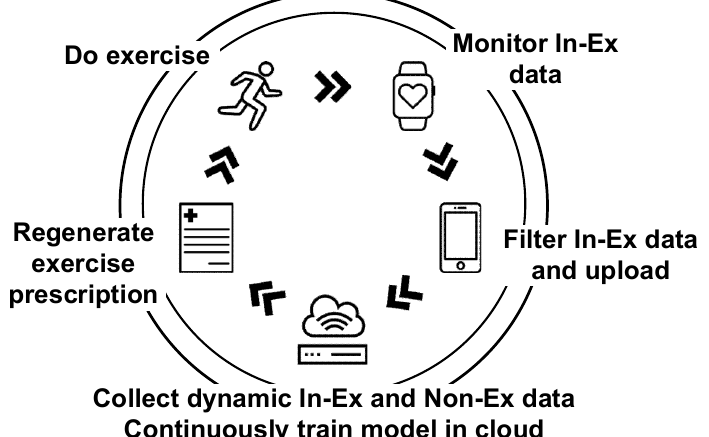
Figure 4. The various parts of the closed loop containing the prediction model.